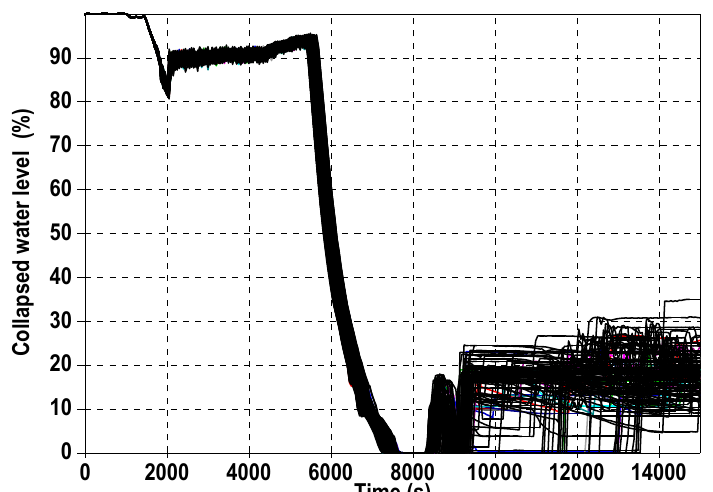
Figure 3. Collapsed water level in the core.